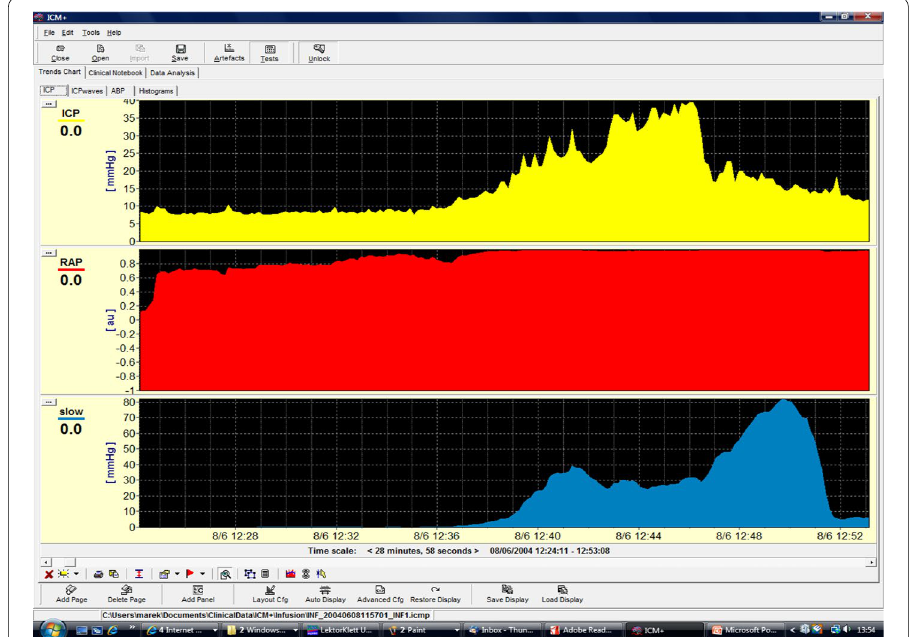
Fig. 4 Example of a constant rate infusion test in post-SAH HCP with B (slow) waves. The same patient as in Fig. 3 where a RAP index close to 1 is associated with an increased power of B (slow) waves during infusion + test. A fast Fourier transformation (FFT) was performed to evaluate the energy (power) of B waves within the